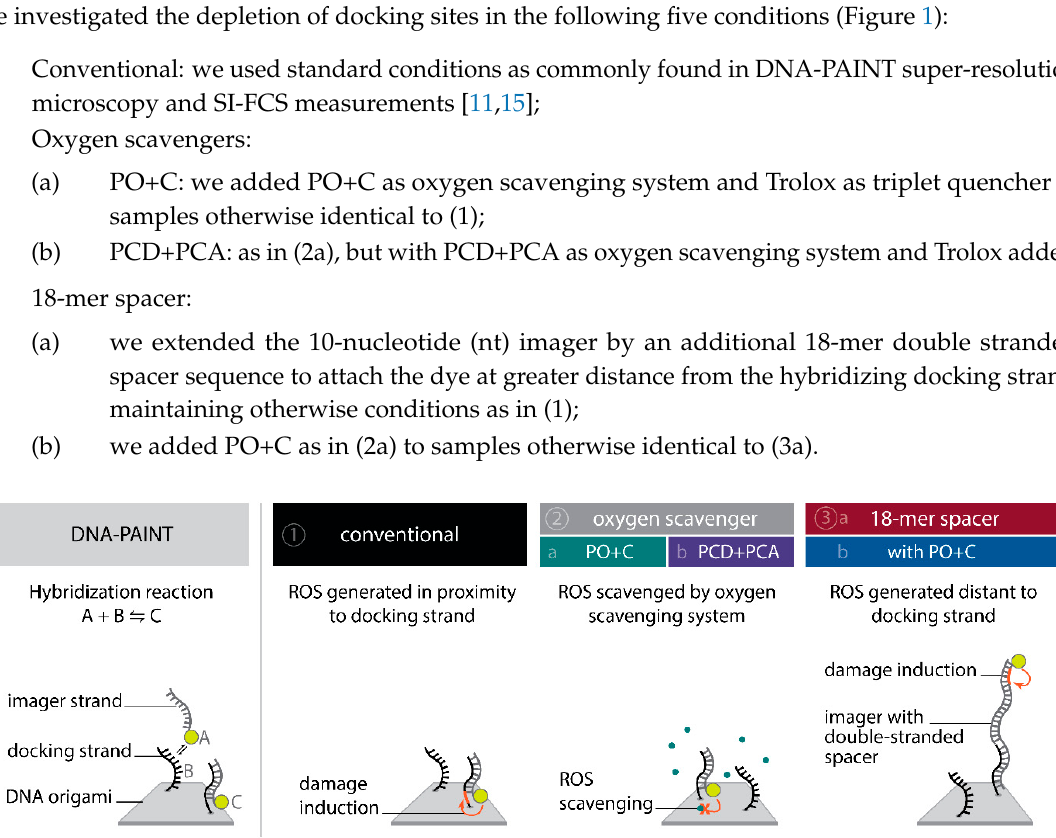
Figure 1. Schematic of DNA-PAINT with the binding of imager strands (A) to docking strands (B) forming the hybridized duplex (C) (left panel). Overview of the conditions to explore the photo-induced depletion of binding sites in DNA-PAINT microscopy and kinetic measurement with SI-FCS (right panel): ( 1 ) conventional 9 nt overlapping imager, ( 2 ) identical imager as in (1) but in presence of a oxygen scavenging system (2a: PO+C or 2b: PCD+PCA), ( 3a ) a modified imager with identical binding sequence and buffer conditions as in (1) but extended by an double-stranded spacer, increasing the distance of dye and docking strand and ( 3b ) the combination of 18-mer spacer and PO+C. ROS scavenging and an increased distance of the fluorescent dye to the docking strand are ought to decrease the rate of depletion of docking sites.